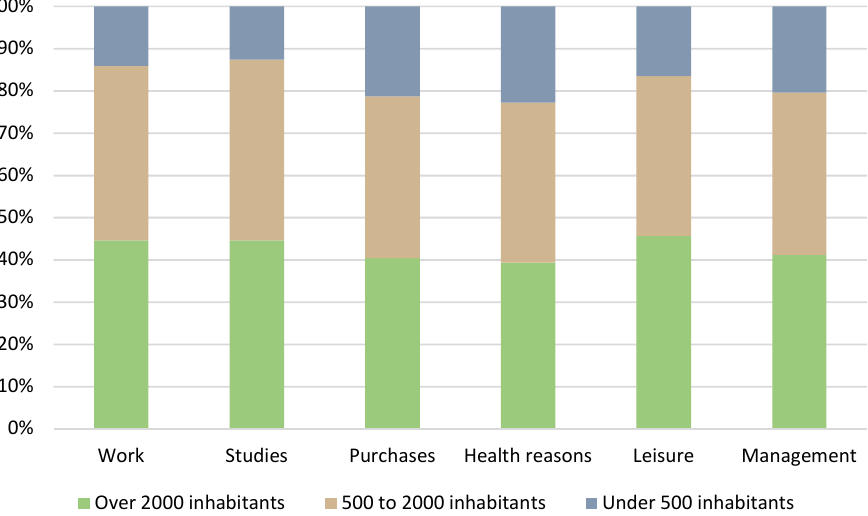
Figure 12. Distribution of trips by reason and population size.